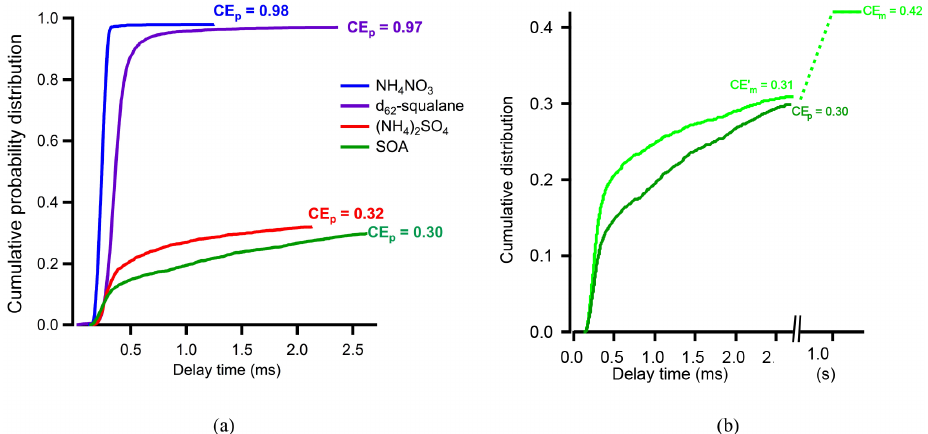
Figure 7. Cumulative particle counts as a function of delay time for SOA, NH 4 NO 3 , (NH 4 ) 2 SO 4 , d 6 2-squalane, and SOA. (a) Cumulative probability distributions of particle counts as a function of delay time for ammonium nitrate (blue), d 62 -squalane (purple), ammonium sulfate (red), and SOA (green). All traces are normalized by the respective CE p values, which are the average value across all experiments for that particle type. (b) Cumulative probability distributions for single-particle counts (dark green) and single-particle mass (light green) for an individual SOA experiment. The dark green trace is scaled by CE p . The light green trace, up to 2.5ms delay time, is scaled by the mass collection efficiency as determined by comparing the AMS-PToF-determined mass to the SMPS mass (denoted CE m ’), according to Eq. (1). The broken axis represents additional mass seen beyond the window of the chopper cycle, and that mass is scaled according to the mass collection efficiency determined by the AMS mass seen in MS mode compared to the SMPS mass (CE m ).